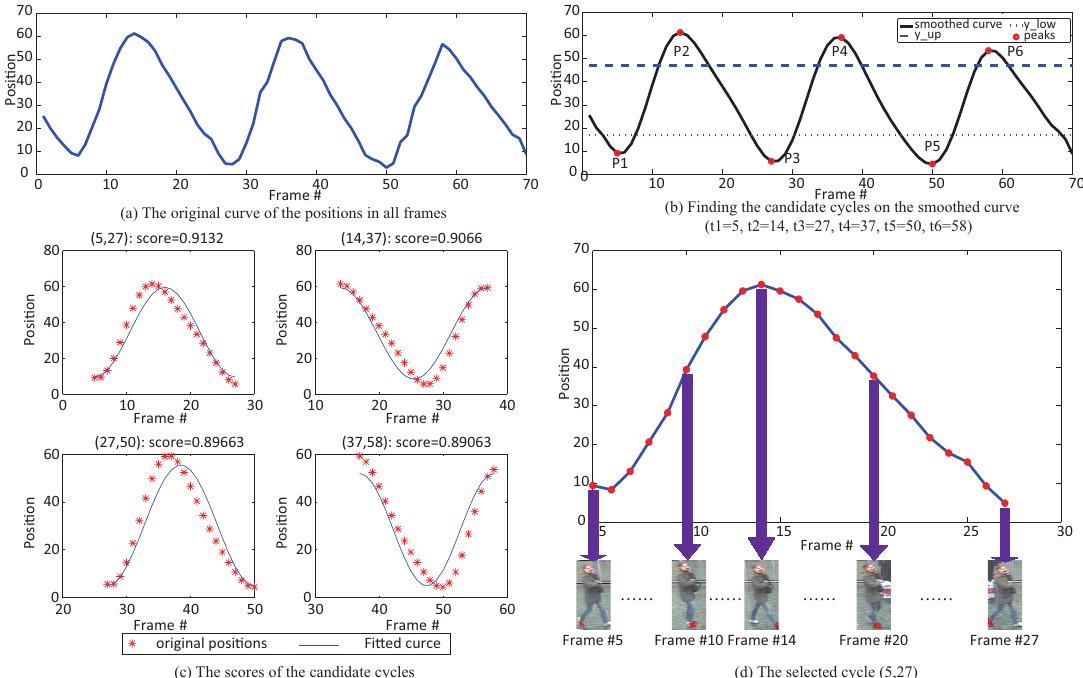
Figure 5. Walking Cycle Extraction. ( a ) the motion curve of a superpixel; ( b ) the smoothed curve, and the extreme points indicated as the red dot. ( c ) Four candidate cycles, (5,27), (14,37), (27,50), and (37,58), and their scores. ( d ) the final selected walking cycle